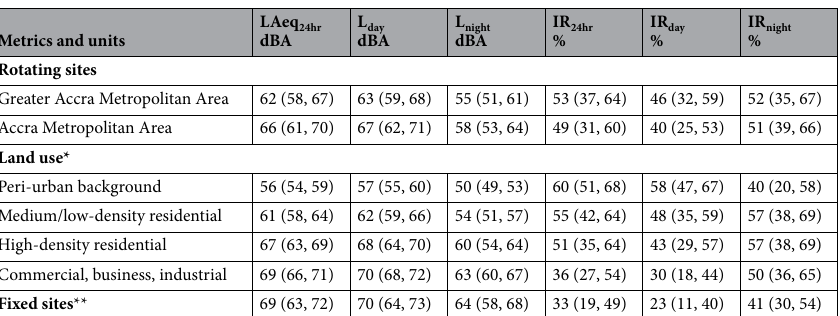
Table 1. Noise metrics in the Greater Accra Metropolitan Area and across land use areas. Data are expressed as medians and interquartile ranges (IQR). Each of the 136 rotating sites have 7-days of measurement and fixed sites have data spanning 12-months. LAeq 24hr : A-weighted equivalent continuous 24-h sound level; L day and L night : A-weighted equivalent continuous sound level in the day and night-time; IR 24hr : 24-h Intermittency Ratio; IR day and IR night : Day- and night-time Intermittency Ratio. *Medium/low-density residential are typically formal residential areas; high-density residential are typically informal residential areas and could be classified as shantytowns or slums; peri-urban background are the least built-up areas and typically have an abundance of forest, grass land, shrubs, barren land, and/or water; commercial, business and industrial areas are places which are dominated by commercial, business, industrial, and/or government activities (see full criteria in S8). **10 fixed sites had 3 CBI areas along major motorways, 2 sites in high-density residential neighborhoods, 4 sites in medium/low-density residential areas and one at a peri-urban background